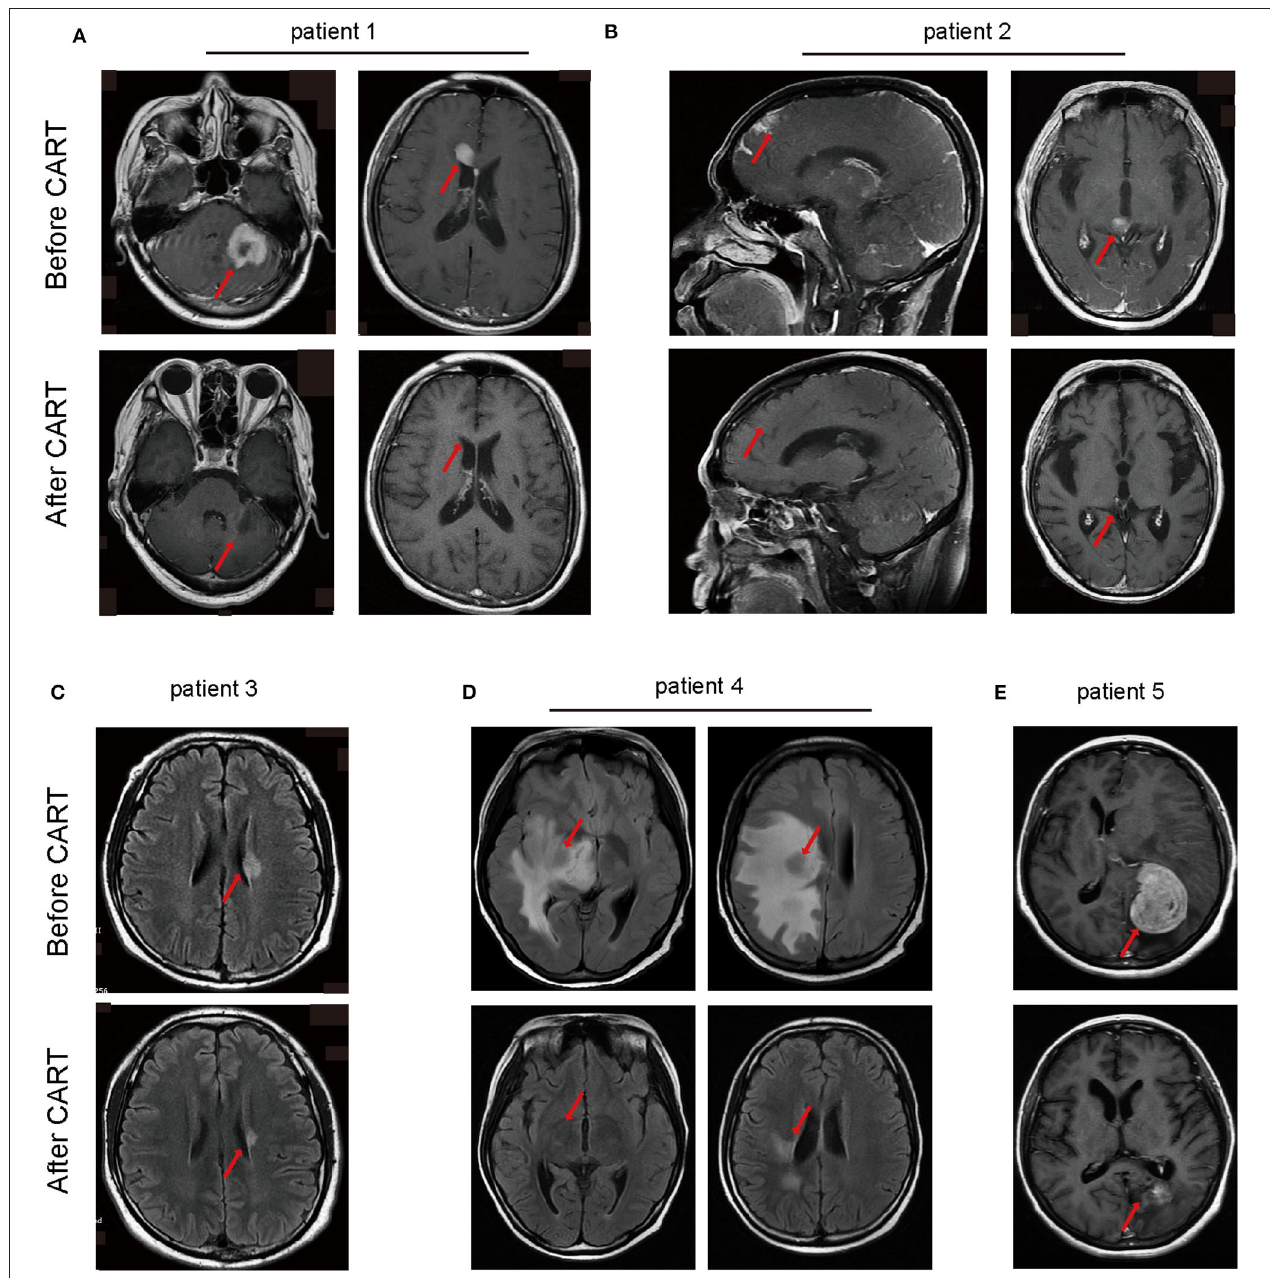
FIGURE 2 | Head MRI imaging manifestations of lymphoma in CNS monitoring the therapeutic effects of CAR-T cell therapy of the five patients. (A) The main central invasion sites of patient 1 are left cerebellum and corpus callosum. (B) Invasion sites of patient 2 are frontal cortex and thalamus. (C) The central invasion site of patient 3 is left lateral ventricle. (D) The main central invasion sites of patient 4 are right basal ganglia, insula, frontal parietal temporal white matter, radiating crown, lateral ventricular trigonometry. (E) The invasion site of patient 5 is left occipital parietal lobe. MRI, magnetic resonance